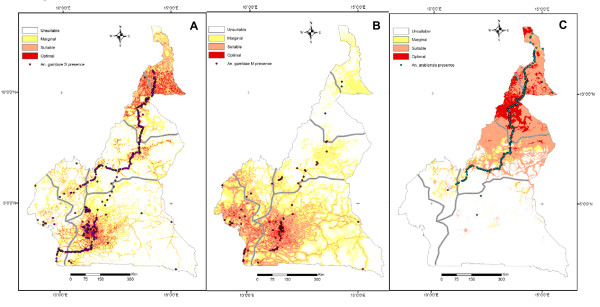
Habitat suitability maps of An. gambiae complex mosquitoes in Cameroon. Habitat suitability (HS) maps showing presence points (black dots) that were used for the ENFA for members of the An. gambiae complex in Cameroon. Habitat quality is classified in four classes of decreasing suitability: optimal (red), suitable (orange), marginal (yellow) and unsuitable (white). A: An. gambiae S form. HS map based on N = 328 presence points showing optimal (4.0% of the total study area), suitable (12.3%), marginal (25.3%) and unsuitable (58.4%) habitat. B: An. gambiae M form. HS map based on N = 80 presence points showing optimal (2.3% of the total study area), suitable (18.3%), marginal (34.7%) and unsuitable (44.7%) habitat. C: An. arabiensis. HS map based on N = 189 presence points showing optimal (5.6% of the total study area), suitable (22.0%), marginal (3.6%) and unsuitable (68.8%) habitat.